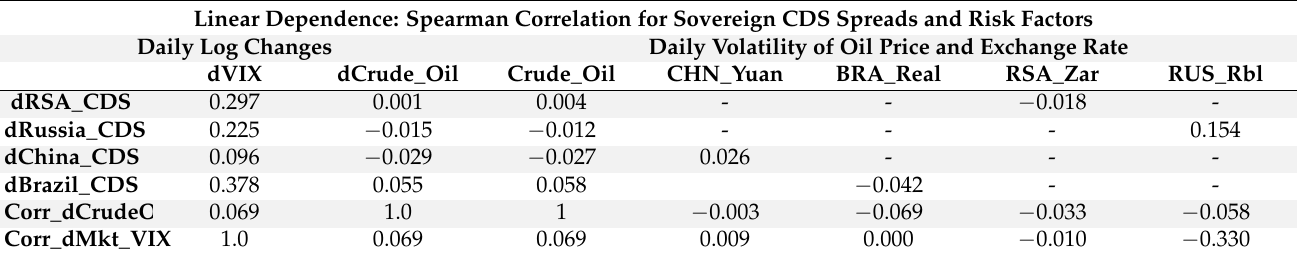
Table 2. Linear correlation of sovereign CDSs and risk